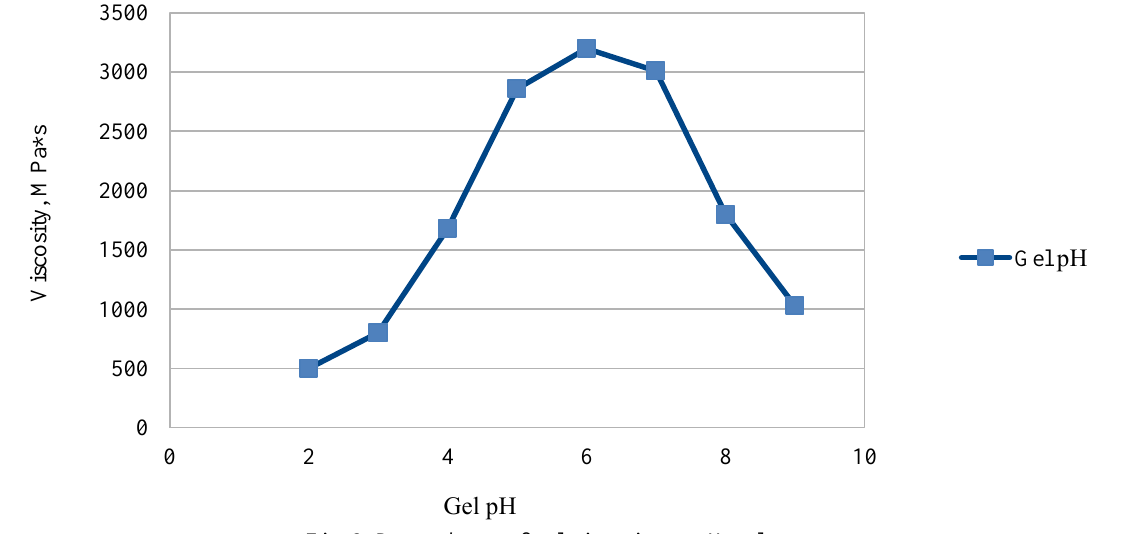
Fig. 3. Dependence of gel viscosity on pH